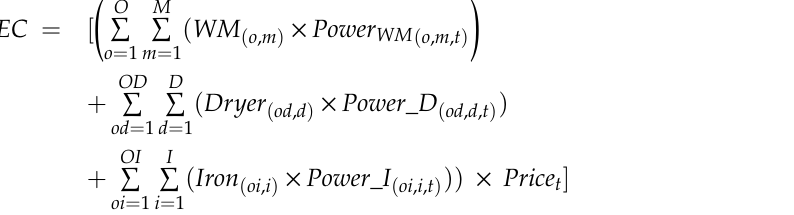
Table 4. Characteristics of different scenarios.